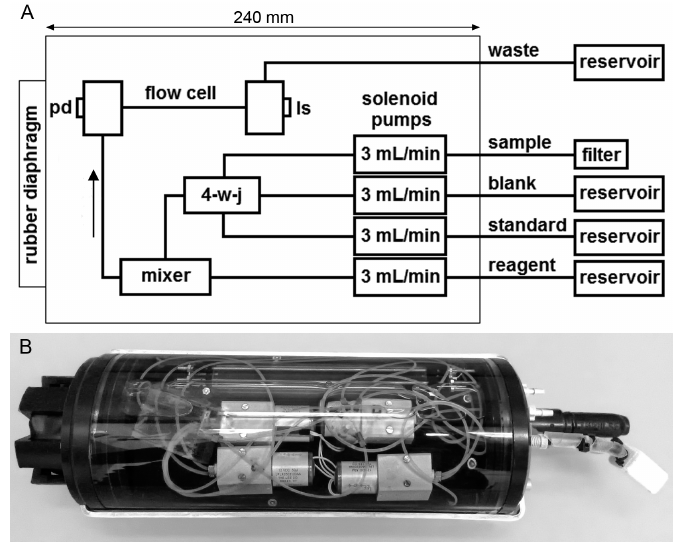
Figure 1. ( A ) Multi-pumping flow system manifold used for the analysis of dissolved Mn. 4-w-j: 4-way junction; ls: light source; pd: photodiode; ( B ) Photo of the METIS analyzer including the coarse sandstone filter for removing large